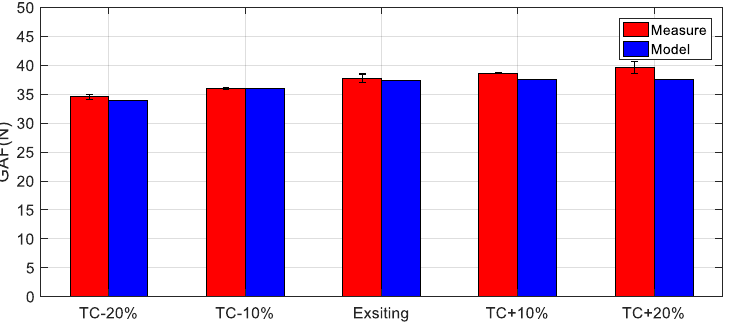
Figure 14. GAF verification results with respect to track curvature.